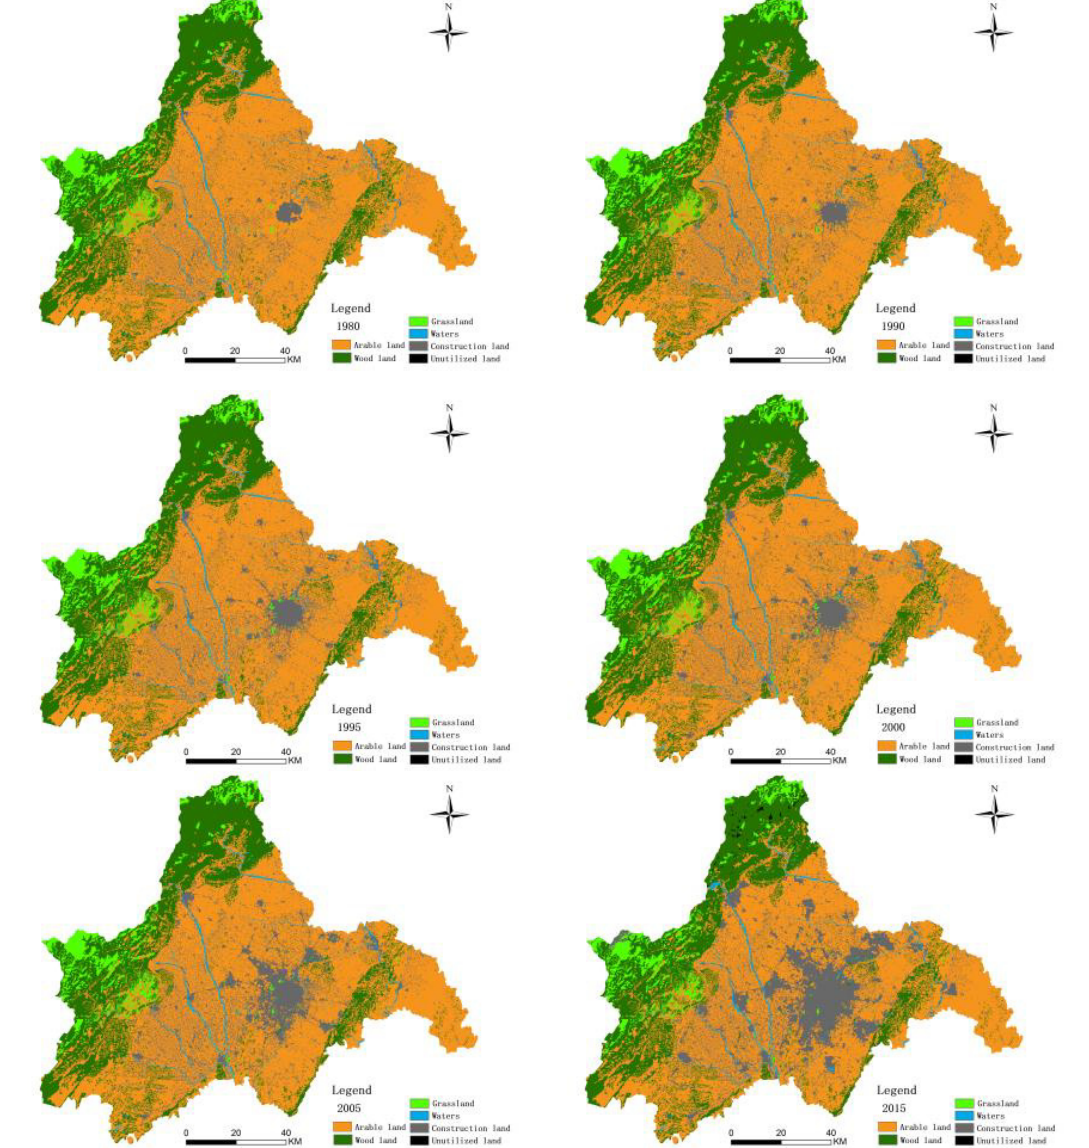
Figure 6. Dynamic changes in land-use in Chengdu from 1980 to 2015.